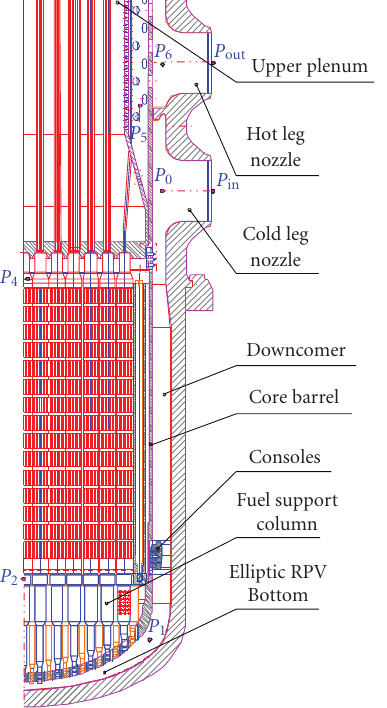
Figure 1: Geometry of the VVER-1000 reactor vessel.